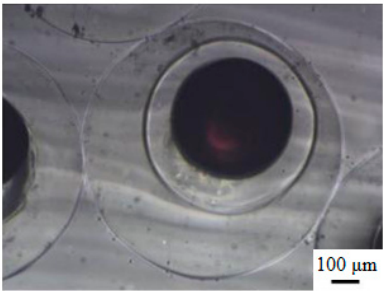
Figure 4. Effect of temperature on the volume ratio of solid P(NIPA- co -MAA) hydrogel microspheres with different MAA molar percentages.